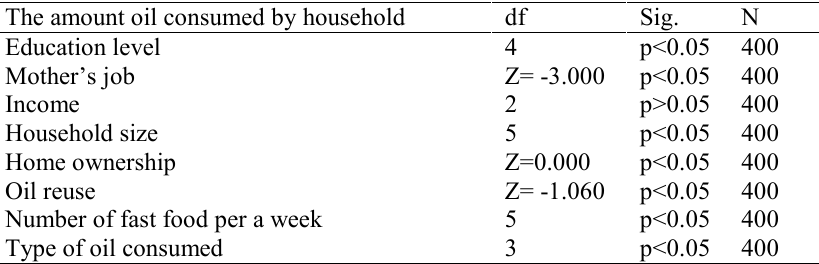
Table 4. Correlations of household oil consumption and influential